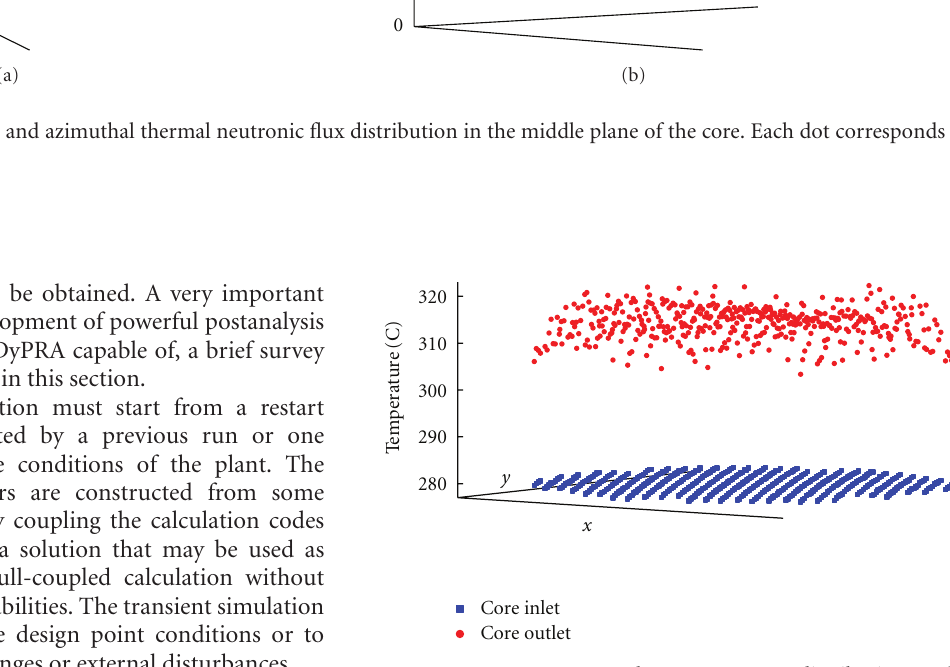
Figure 9: Instantaneous coolant temperature distribution at the inlet and outlet of the active zone at full power.